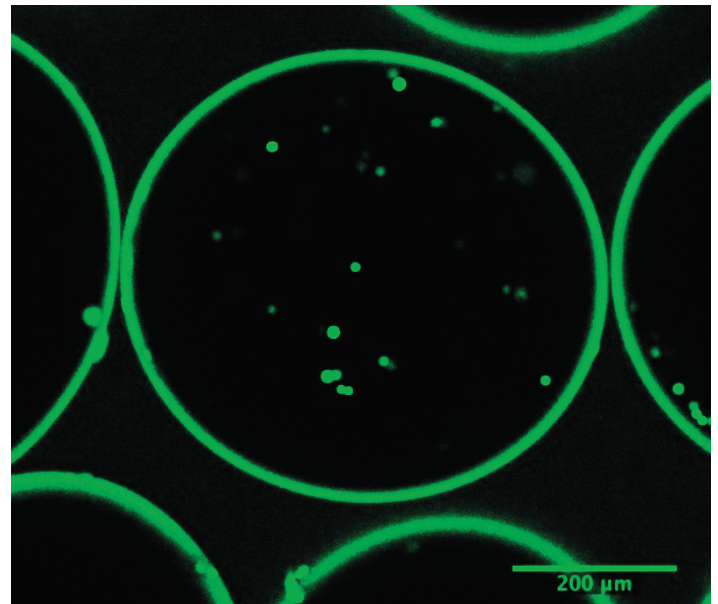
Figure 8. Confocal image of calcium-alginate poly- L -lysine-alginate microcapsules, immediately after inoculation. The average microcapsule radius is 260 μ m and the membrane thickness, 18 μ m. The stained cells fluoresce green if viable, or red if dead.